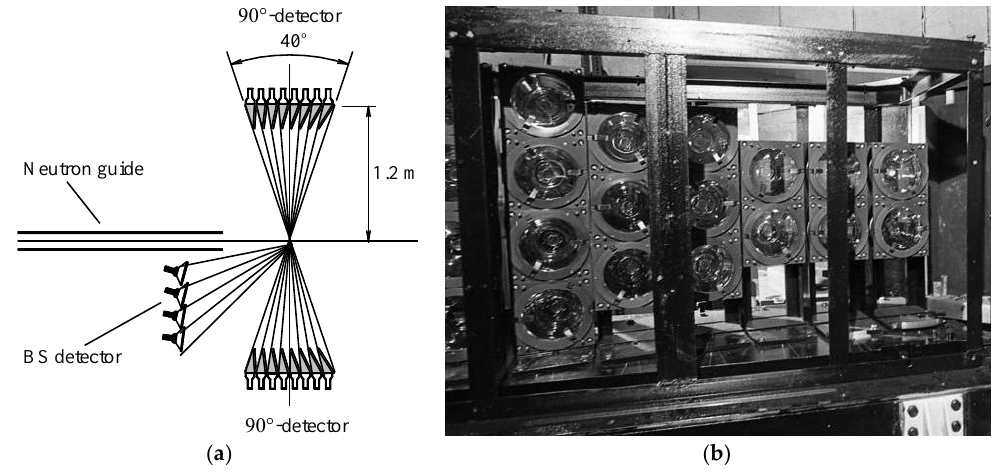
Figure 6. ( a ) Detector system of the FSD diffractometer, adapted from [25], with permission from © 2010 Springer; ( b ) Time-focused backscattering detector BS (shielding is removed).